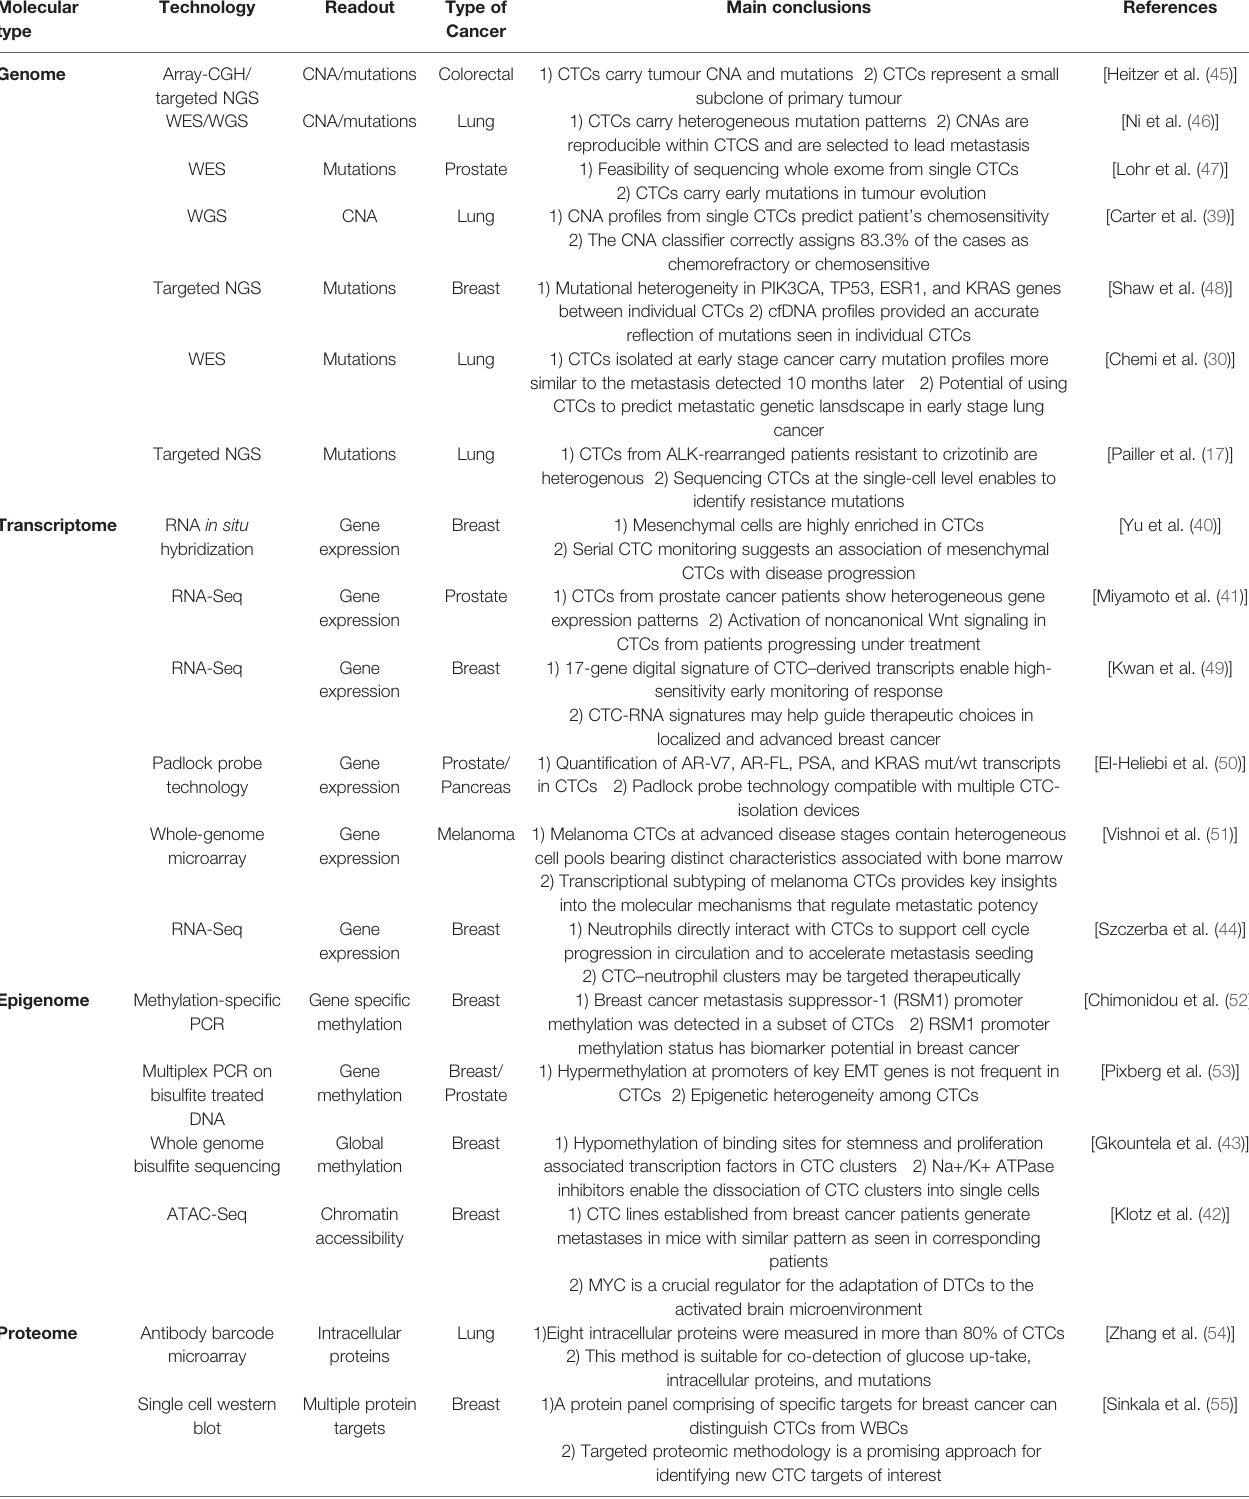
TABLE 1 | Summary of studies that performed CTC molecular pro fi